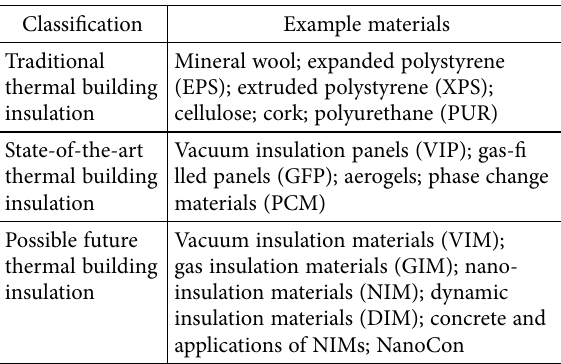
Table 1. The division of thermal insulation materials by Bjørn (2011) (cited from Dylewski, Adamczyk 2014) Classification Example